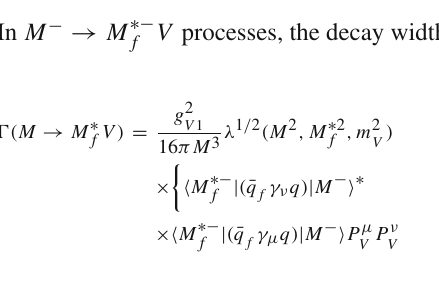
limitsofbranchingratiosareoftheorderof10 − 6